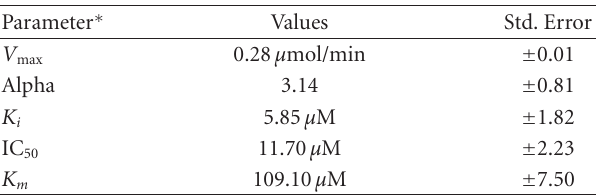
Table 1: The parameters of PG-1 Inhibition potential